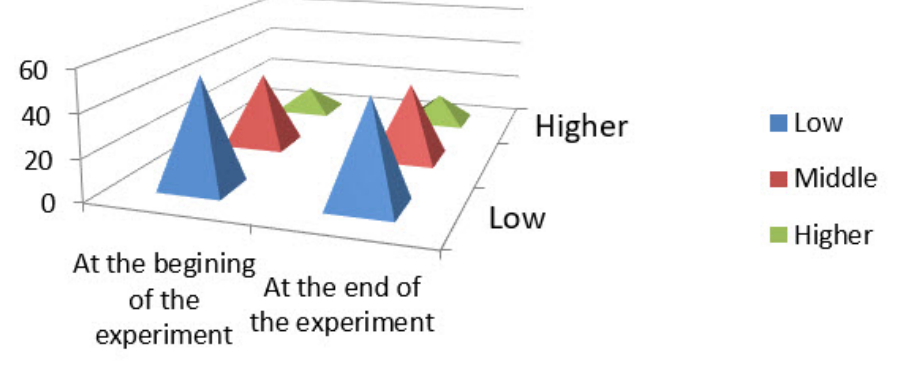
Figure 1. Chart of interest rates at the beginning and end of experimental group control